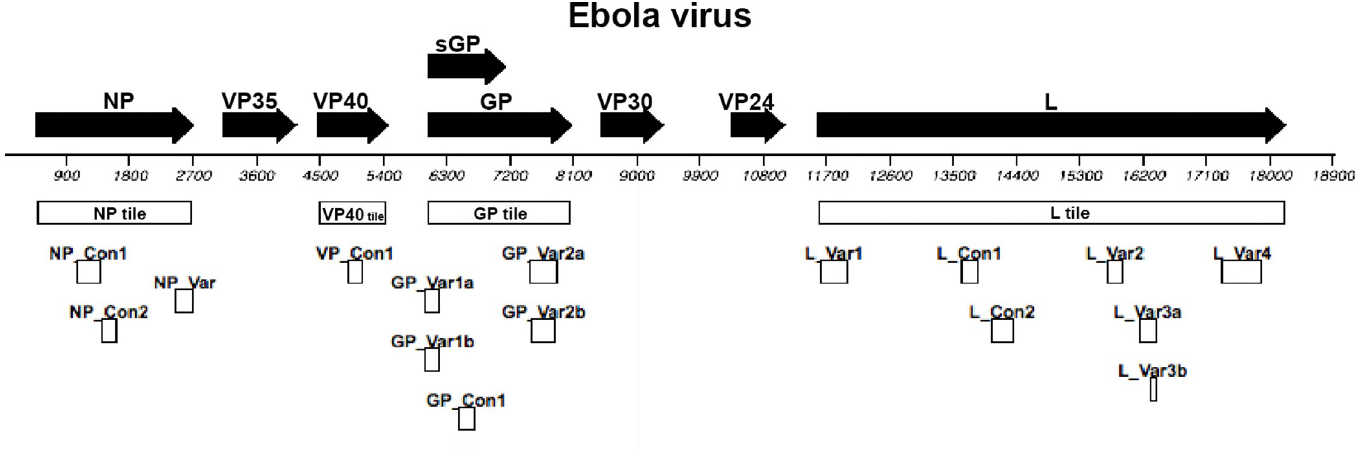
Fig 1. Microarray tile design. The full genome of Ebolavirus is indicated by the black line with bases numbered. The filled black arrows indicate the coding sequences for the eight virus proteins. Genes encode nucleoprotein (NP), nucleocapsid-associated (VP24) viral proteins (VP35, VP30), matrix protein (VP40), and RNA polymerase containing Large protein (L). The glycoprotein (GP) gene encodes four proteins, resulting from RNA editing and proteolytic cleavage: transmembrane GP 1,2 , secreted glycoprotein (sGP and ssGP), and the delta peptide which is the C-terminal cleavage product of the sGP precursor. The white boxes indicate the location of the sequences that are covered by the overlapping probes called “tiles” on the microarray. Conserved sequence tiles (Con) and variable sequence tiles (Var) are indicated as the smaller boxes below the full coding sequence tile in the position of the sequence covered. There are separate sets of tiles for Ebola virus, Bundibugyo virus, Ta ï Forest virus, and Sudan virus (shown in S1 Fig). There are 83 tiles over the four evaluated Ebolaviruses, covering 11,842–11,850 bases (~62%) of the genome depending on the Ebolavirus.